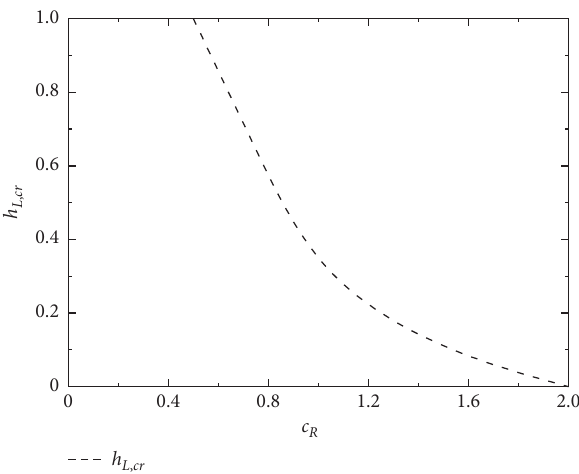
Figure 14: Relationship between the critical height of the left leg ( h L,cr ) and the distance from the right support to the center of the platform c R .